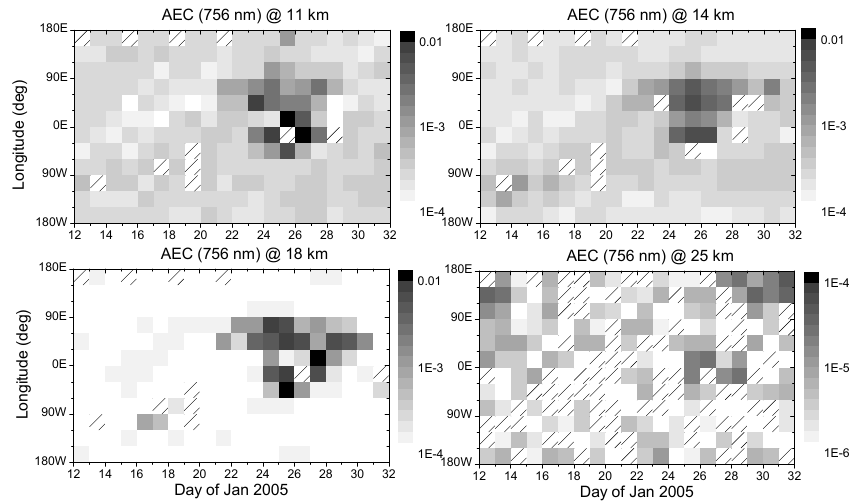
Fig. 3. Daily averaged aerosol extinction coefficient (in km − 1 ) at the 756nm wavelength measured by SAGE III instrument at fixed altitudes (as denoted on top of each panel) as a function of geographical longitude. Logarithmic grey scale is shown on the right of each panel.